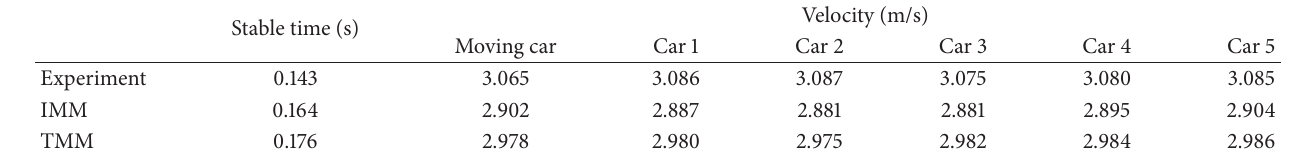
Table 5: Velocities of bodies at stable